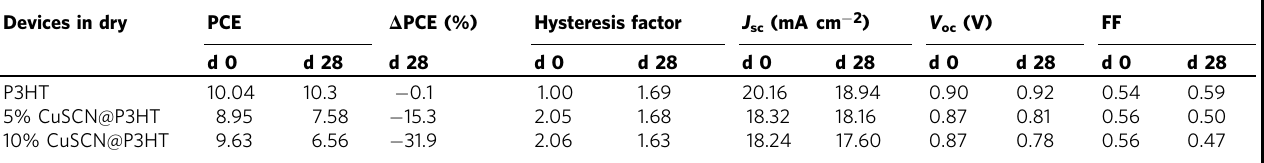
Table 2 Average fi gures of merit for PSC measured as prepared (d 0) and after 28 days (d 28), stored in a dry box ( “ dry ”